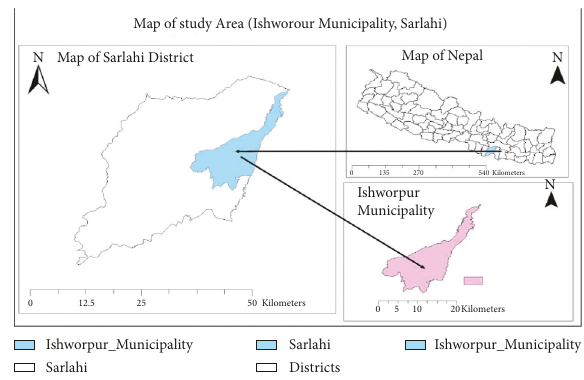
Figure 1: Map of the study